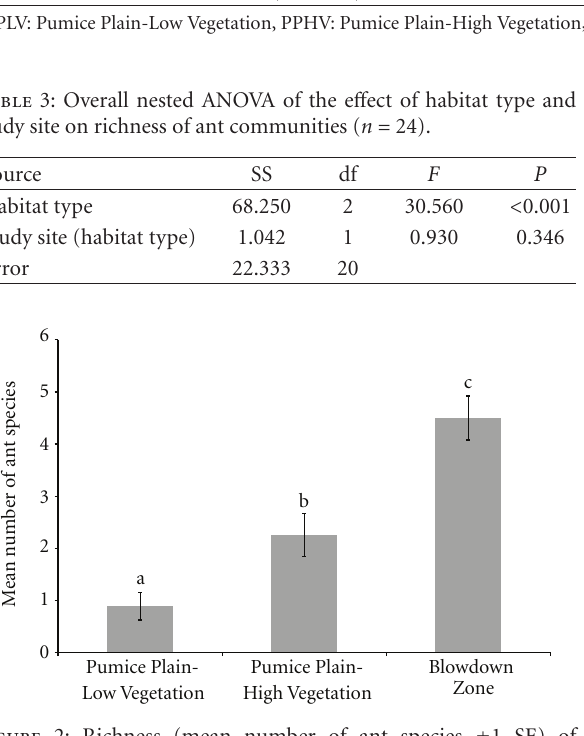
Figure 2: Richness (mean number of ant species ± 1 SE) of ant communities in three habitat types at Mount St. Helens National Volcanic Monument sampled between 22 and 25 July 2008. Di ff erent letters above the bars indicate significant di ff erences ( P < 0 . 01) between habitat types.